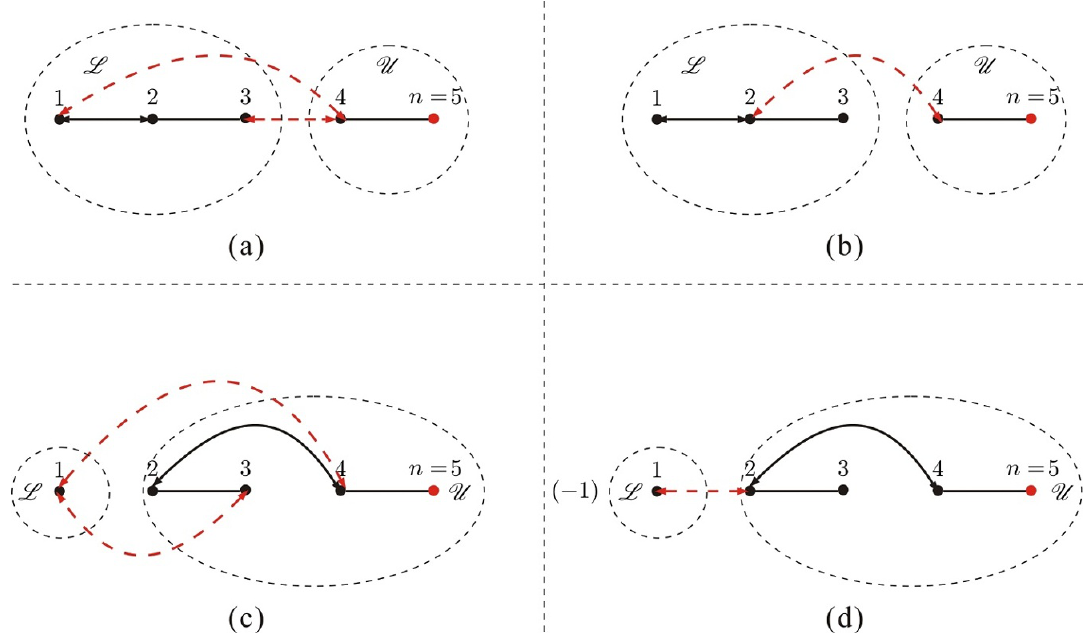
Figure 21 . Graphs (a) and (c) are physical graphs corresponding to the skeleton (cid:12)gure 20